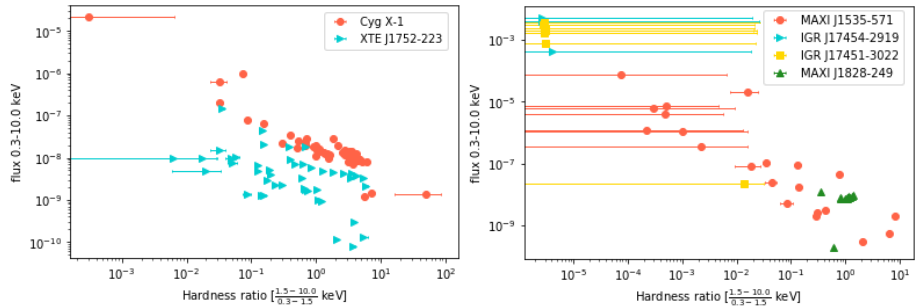
Fig. 7. Hardness-intensity diagrams of Cyg X-1 and XTE J1752-23 (left-hand panel) and the candidates (right-hand